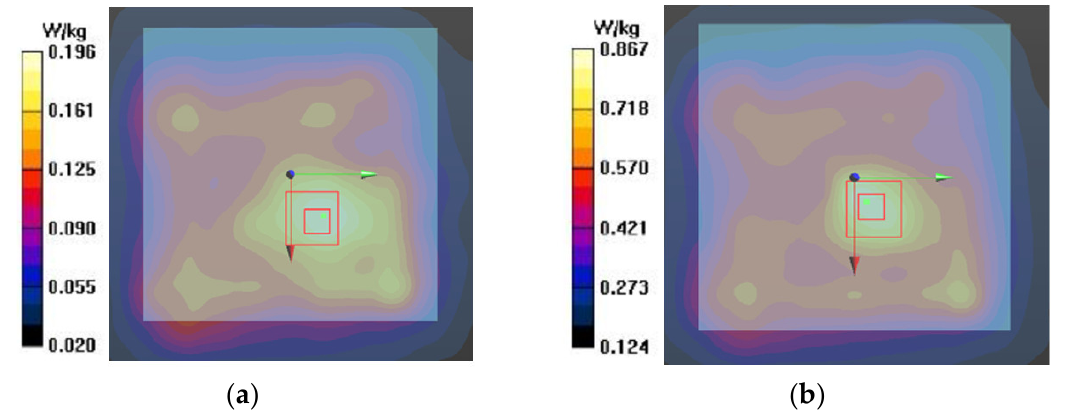
Figure 16. Measured SAR distribution: ( a ) 2.45 GHz and ( b ) 5.8 GHz. Red boxes indicate the hot spot.